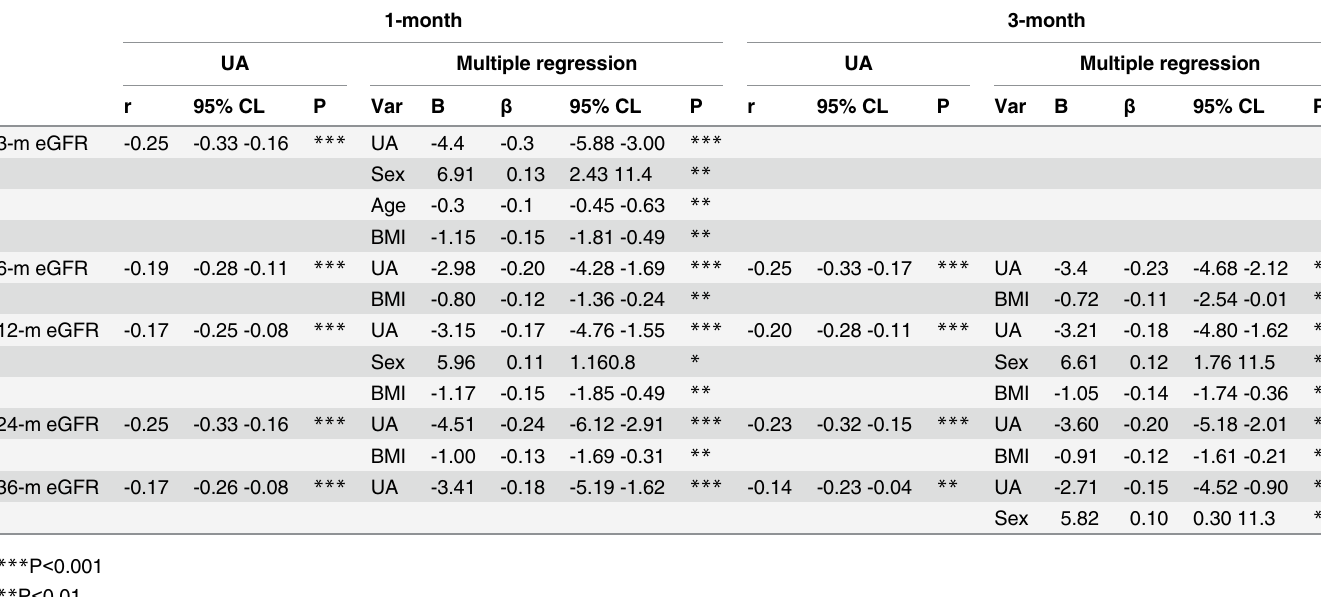
Table 4. Prediction of renal function with early post-transplant UA levels using linear regression models. 95%CL, confidential interval for unstan- dardized B; r, correlation coefficient; Var, variables; B, unstandardized regression coefficient; β , standardized regression coefficient; Sex, presence for male gender and lack for female; multiple regression model includes UA, gender, BMI, age, introduction regimen, immunosuppressive agents, diabetic mellitus and triglyceride level; include criteria: P < 0.05 and P > 0.1 for exclude criteria;